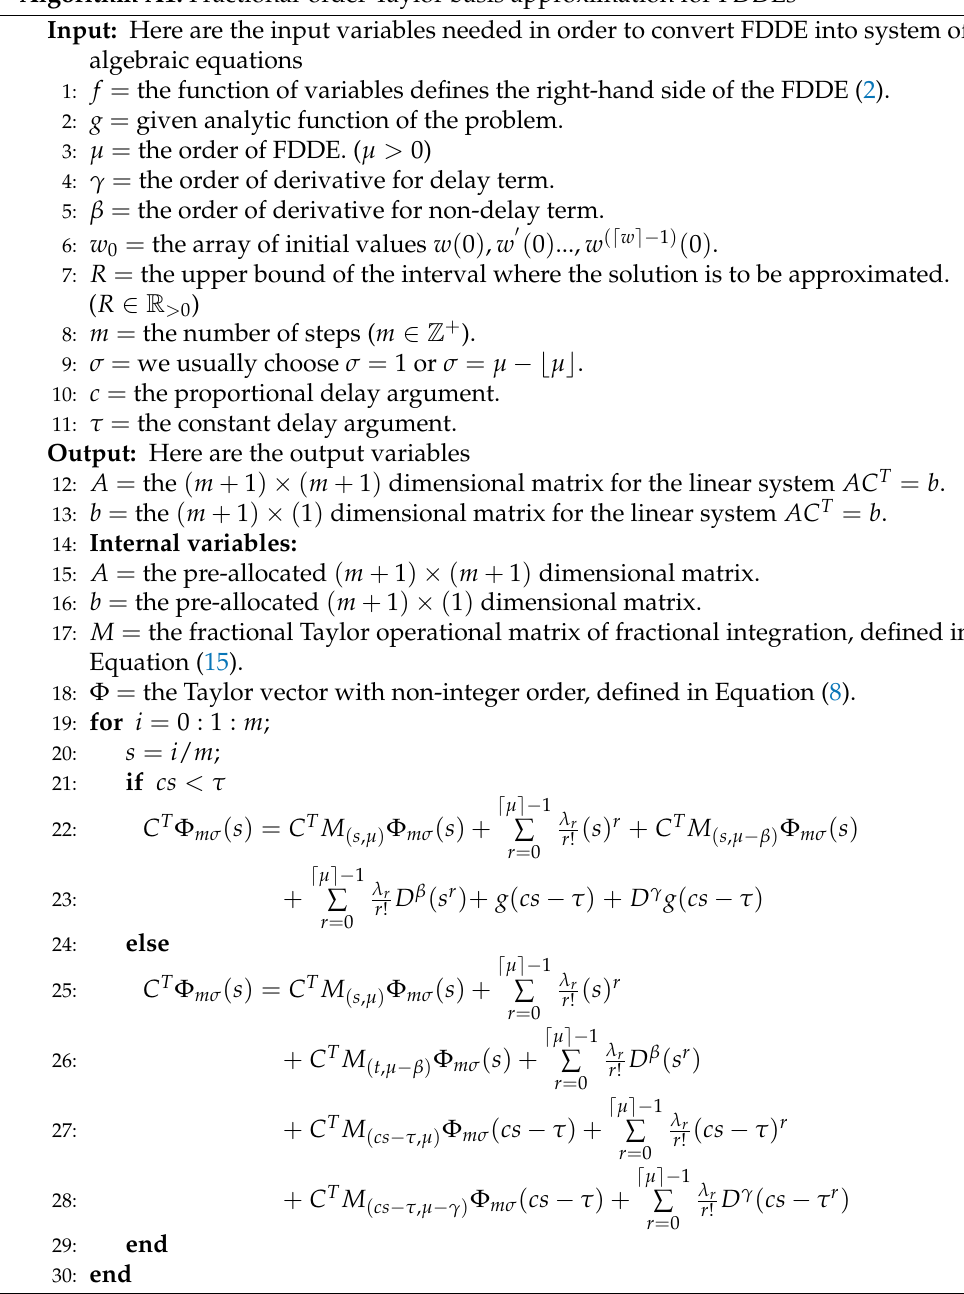
Algorithm A1: Fractional-order Taylor basis approximation for